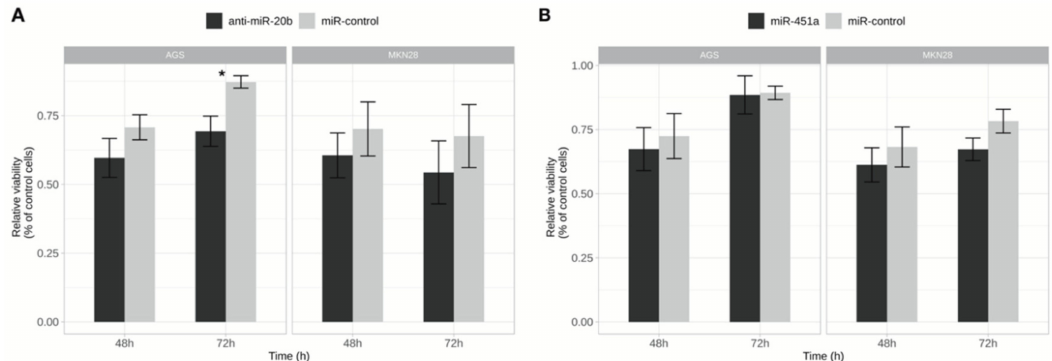
Figure 4. Exogenously altered expression of miR-20b e ff ected cell viability. ( A ) Relative viability changes of AGS and MKN28 cells after inhibition of miR-20b 48 h and 72 h after transfection. Significant results evaluated in AGS cell lines 72h after transfection (* p < 0.05); ( B ) Relative viability changes of AGS and MKN28 cells after increased expression of miR-451a 48 h and 72 h after transfection. Data from four independent experiments.